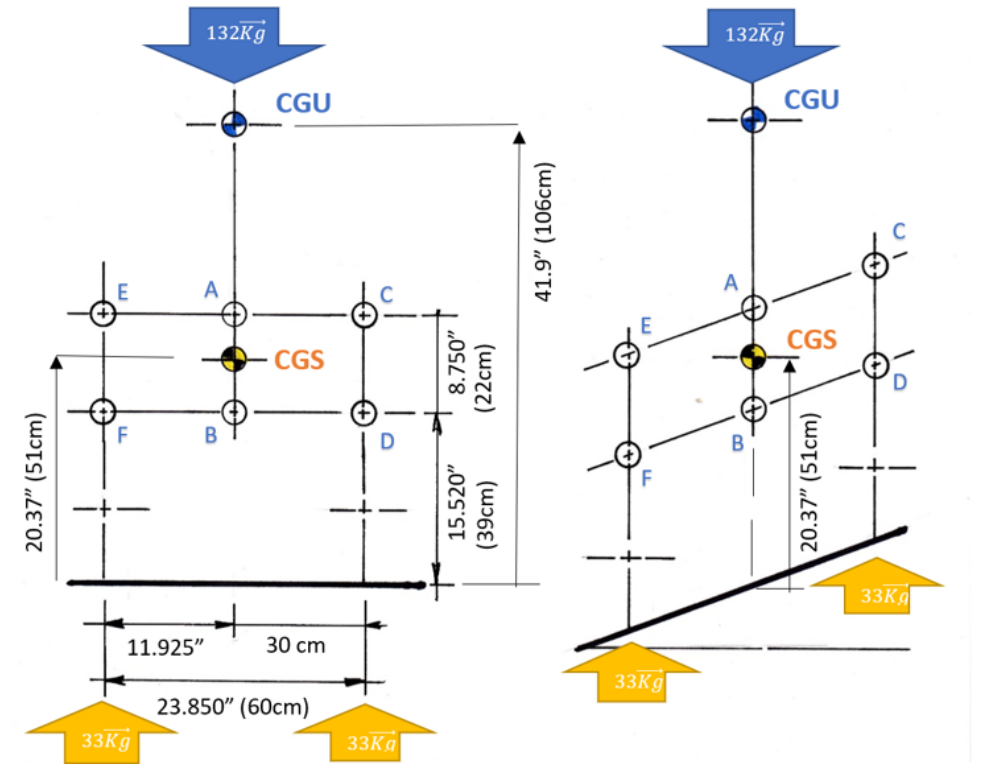
Figure 12. Simplified model of the coronal stability system. ( Left ) Coronal, ( Right ) Sagittal. 3.